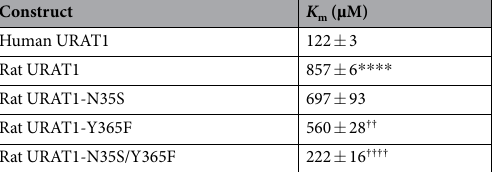
Table 3. Summary of uric acid transport affinities of human URAT1, rat URAT1 and rat URAT1 point mutants at residues 35 and 365. Affinities in K m were obtained from saturation transport curves as in Fig. 5, and are the mean ± SEM of at least three experiments. Data for human URAT1, rat URAT1 and rat URAT1-Y365F were previously reported in Tan et al ., 2016. Statistical analyses are based on unpaired, two-tailed tests. ** p < 0.01,